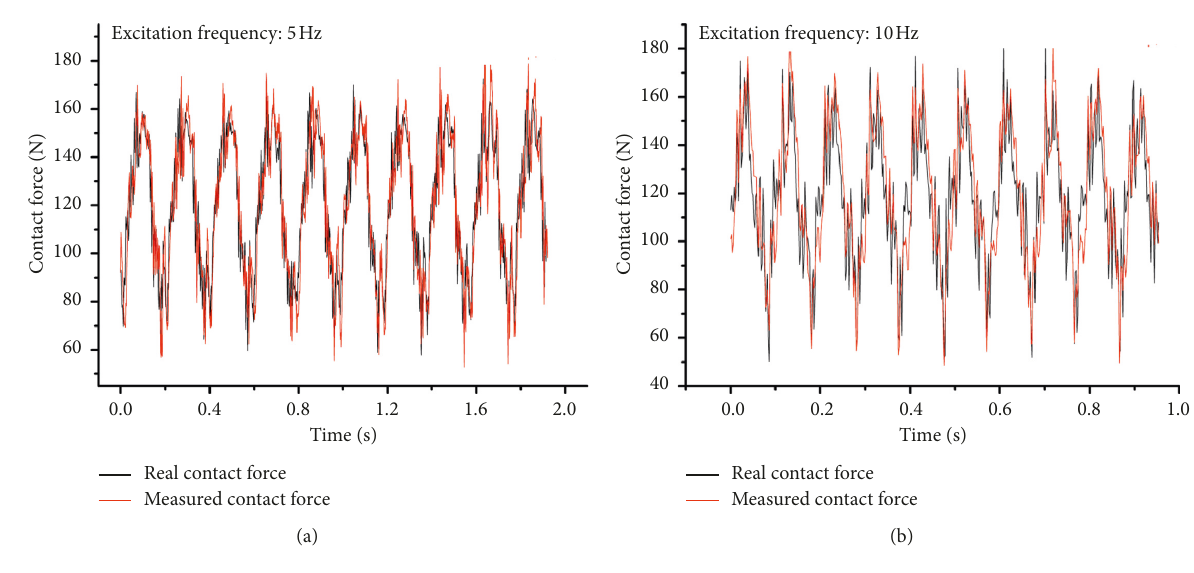
Figure 5: Comparison of contact forces. (a) 5 Hz. (b)